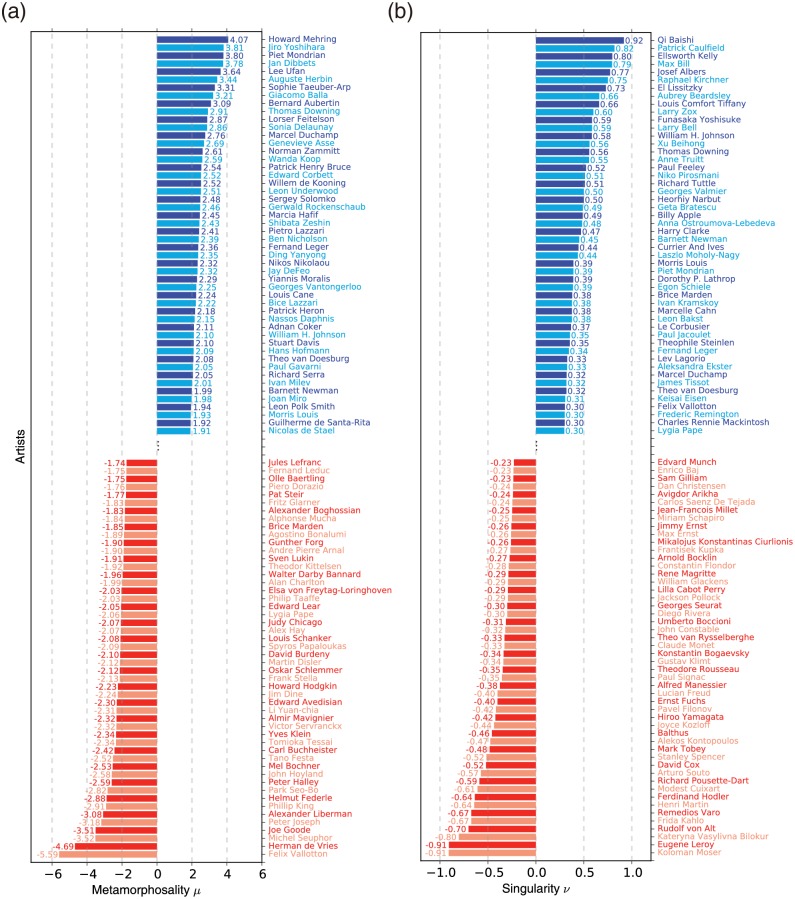
Modern painters with the highest metamorphosality or singularity.(a) The 100 artists with the strongest metamorphosality μ (50 positively, 50 negatively). American painter Howard Mehring made the most significant shift from low-S to high-S during his career (top), while Felix Vallotton was the opposite (bottom). (b) The 100 artists with the strongest singularity ν (50 positively, 50 negatively). Qi Baishi’s works contain the highest fraction of singularly high-S paintings, while Kolomon Moser was the opposite.